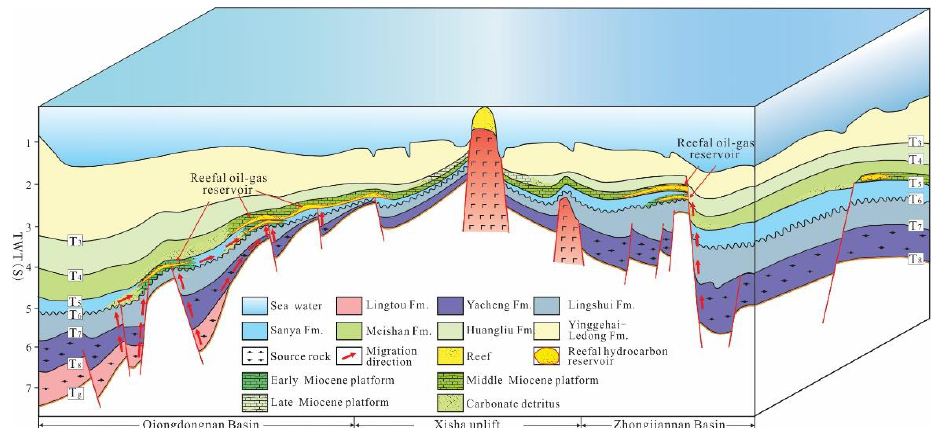
Figure 13. Reservoir prediction for reefs and carbonate platforms in the Xisha sea area.